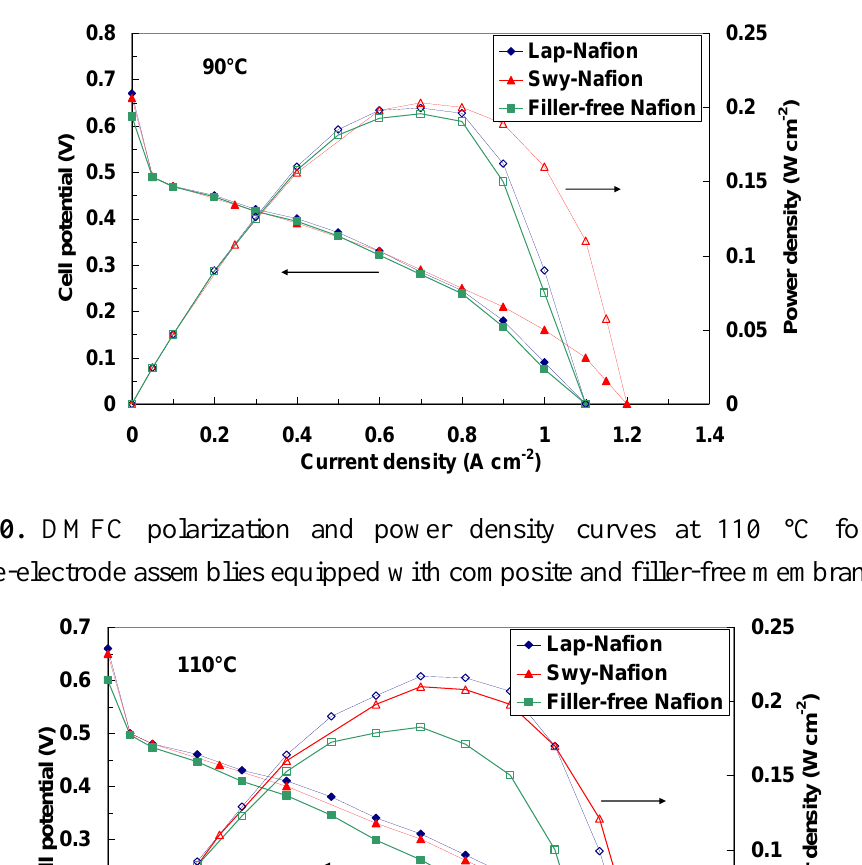
Figure 9. DMFC polarization and power density curves at 90 °C for various membrane-electrode assemblies equipped with composite and filler-free membranes.